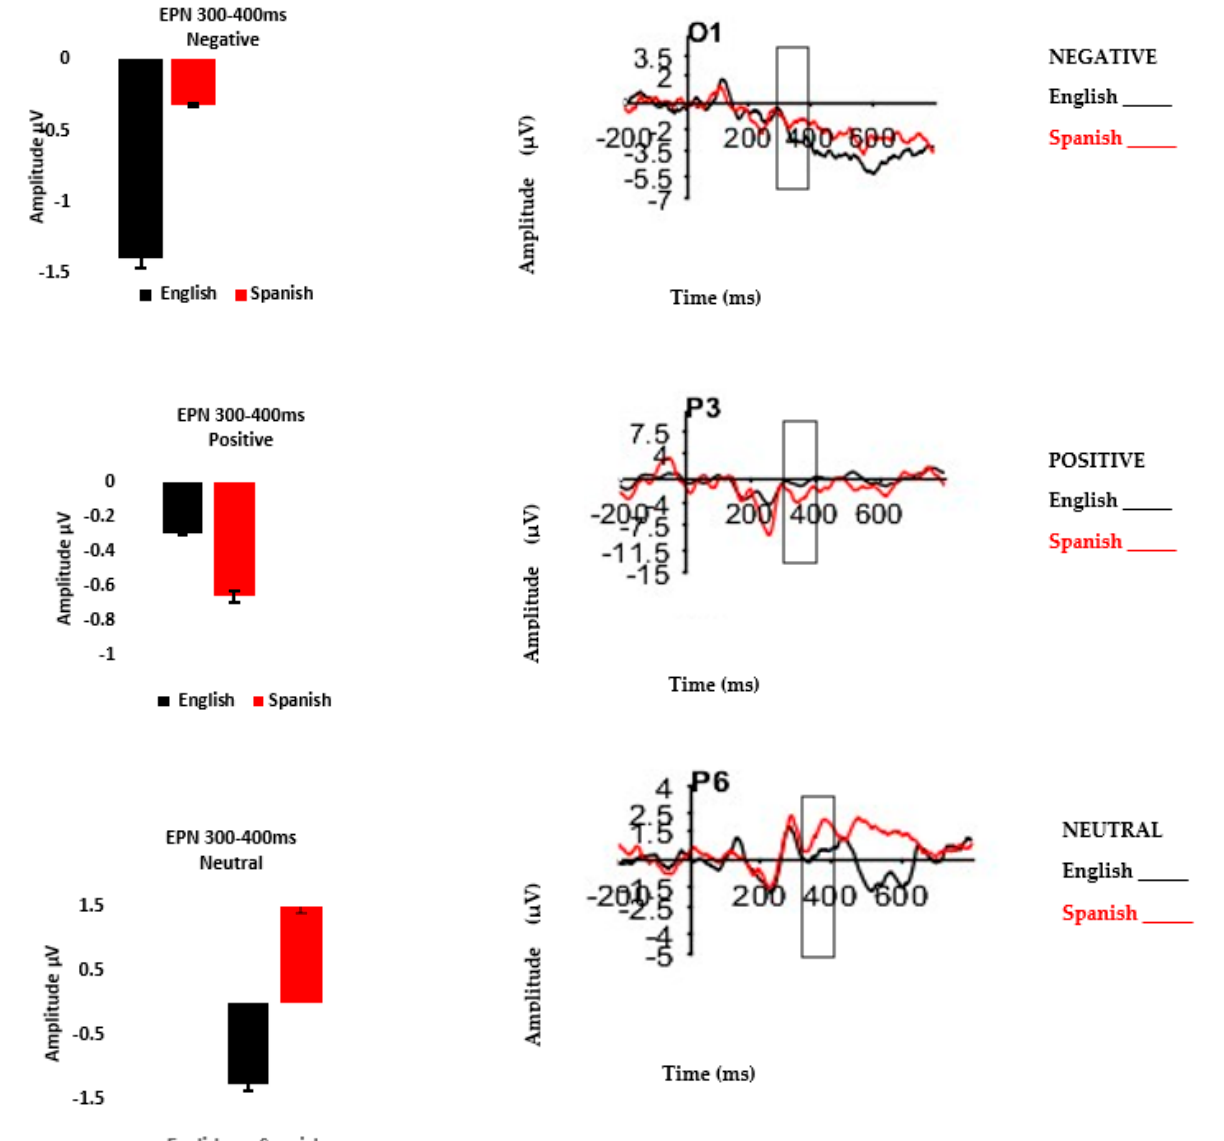
Figure 3. Amplitudes recorded for EPN 300–400 ms as a function of language of the target stimulus and valence. Representative electrodes O1, P3, and P6 illustrate differences in the EPN responses between English and Spanish negative, positive, and neutral targets. Bar plots show posterior EPN activity averaged across the posterior electrodes and the entire time window for EPN 300–400 ms. Error bars are standard errors.